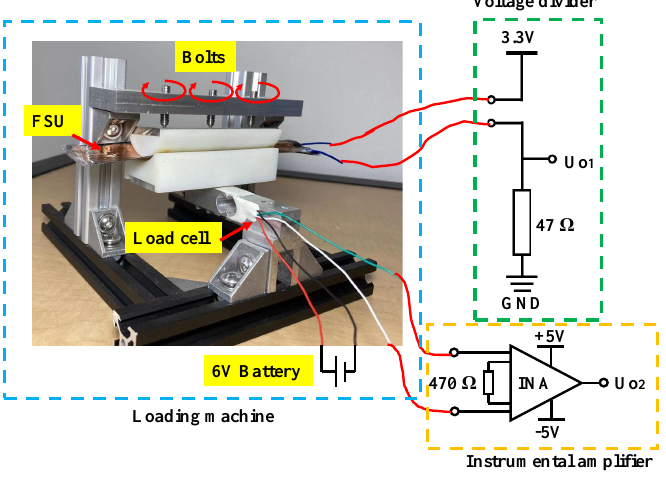
Figure 5. The calibration platform for the